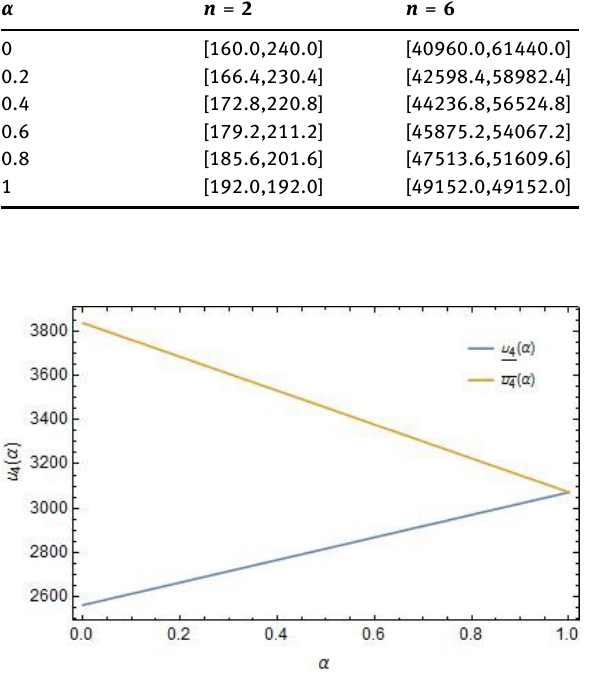
Fig. 2: Solution of u n ( α ) = ⌊ u n ( α ), ¯ u n ( α ) ⌋ for n = 4 of Example 5.1